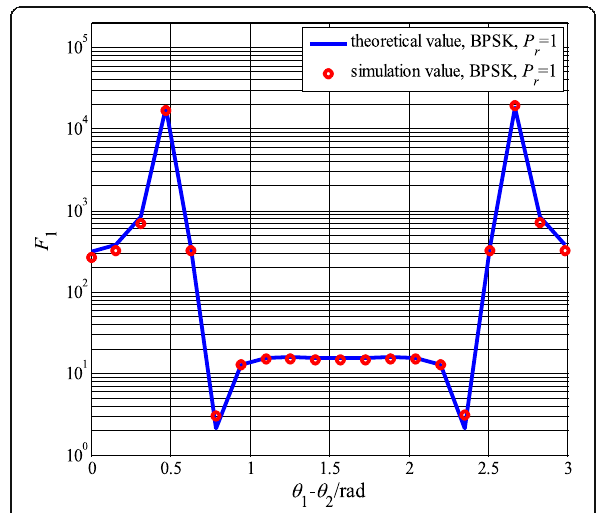
Fig. 8 The HOS feature F 1 as a function of the phase difference when the two signals are BPSK modulated and ω 1 = ω